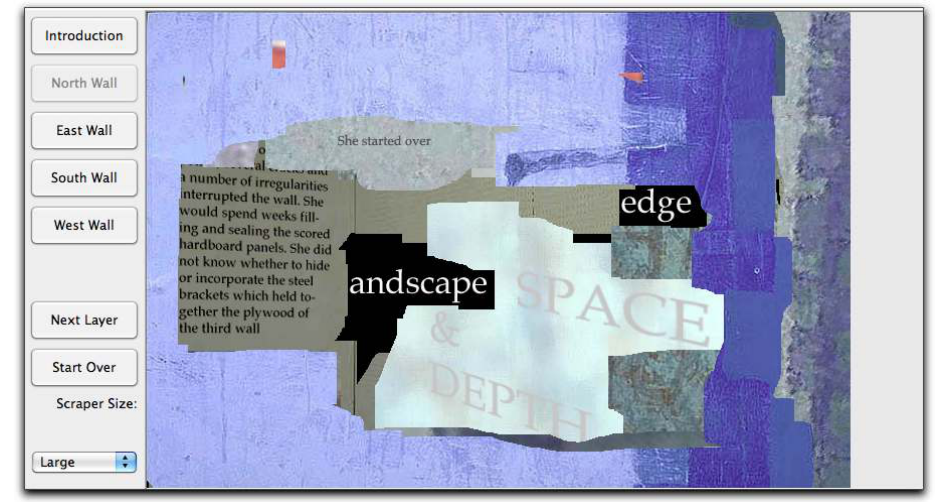
Jerome Fletcher, Geoffrey Olsen, Toby